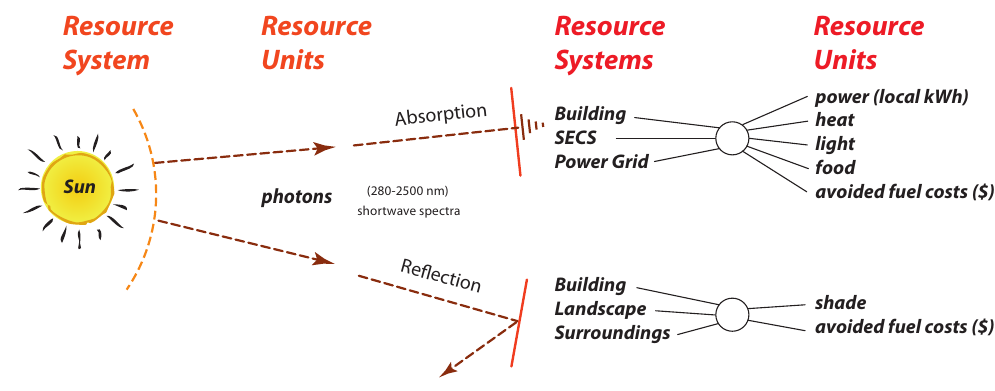
Figure 3. Schematic of the Sun (and emitted shortwave light) as a resource system , and the resulting resource units that are appropriated by the clients who own a solar energy conversion